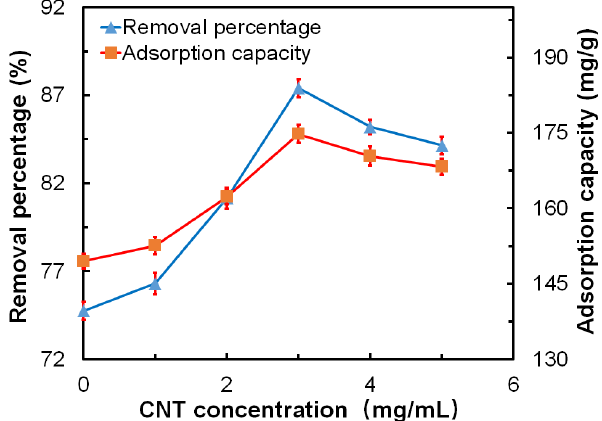
Figure 7. Influence of the CNT concentration on the removal percentage and adsorption capacity of the GO ‐ CNT/AC composites [Conditions: adsorbent amount = 100 mg, MB solution amount = 100 mL, MB solution concentration = 200 mg/L, pH = 7, adsorption time = 300 min, CNT concentrations were 0, 1, 2, 3, 4 and 5 mg/mL,